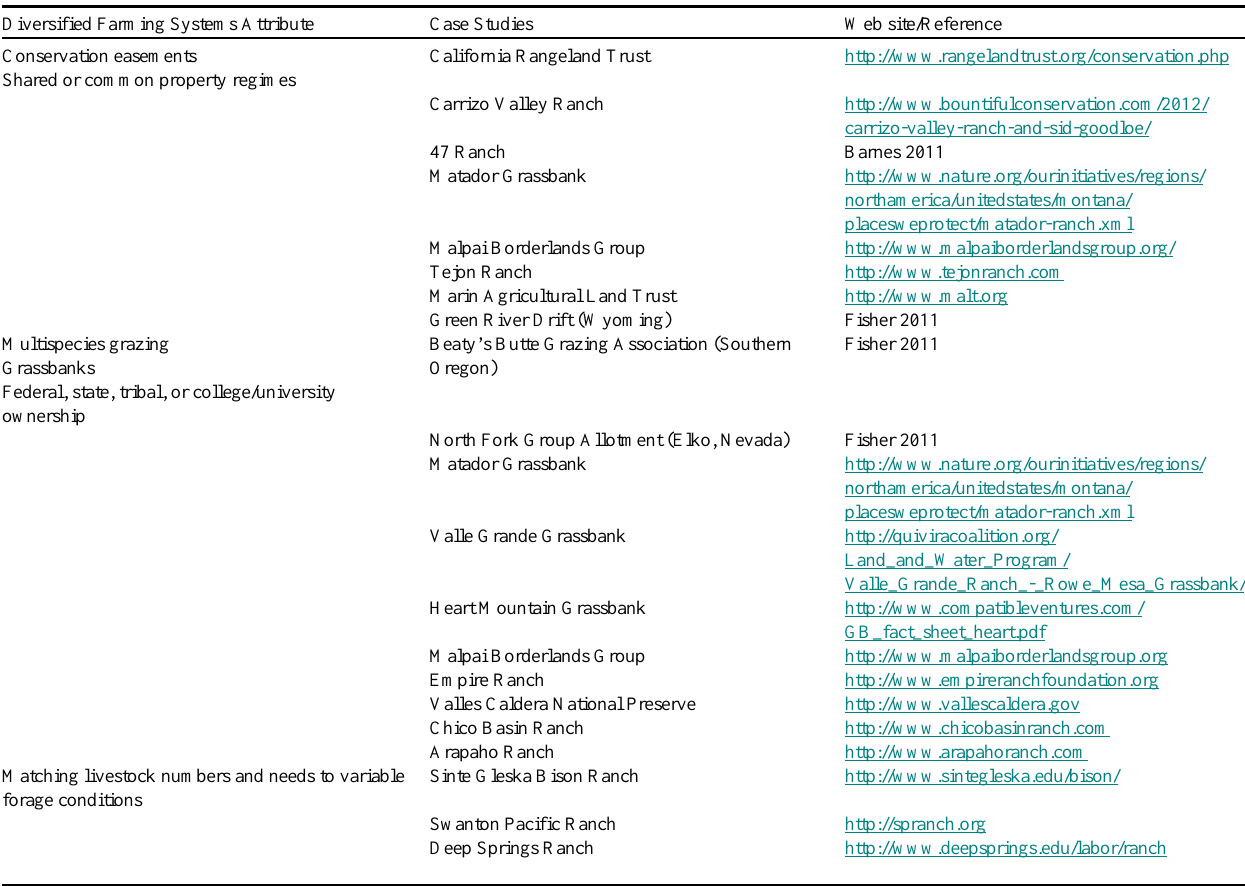
Table 2 . Diversification of land access and tenure